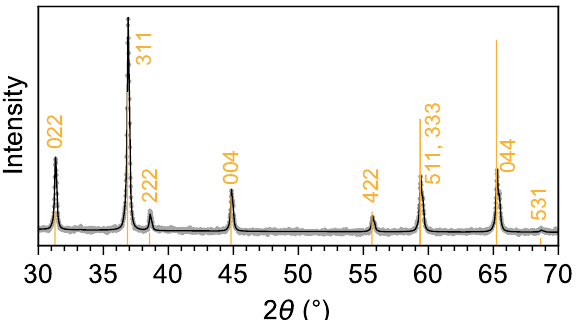
Figure 1. XRD and Rietveld fit for the cobalt oxide specimen used in the experimental study. The diffractogram can be described fully by the spinel oxide Co 3 O 4 with a lattice parameter of 8.083Å